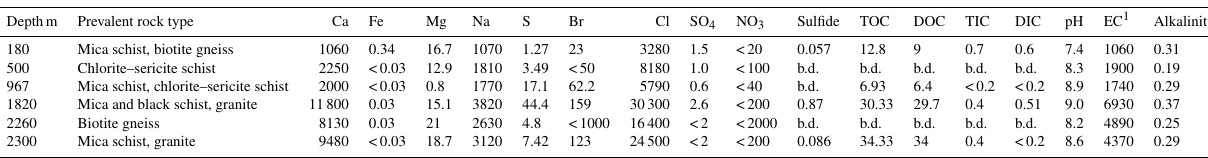
Table 1. Hydrogeochemical characteristics of six fracture zones of Outokumpu. Concentrations for cations and anions are given in mgL − 1 , EC in mSm − 1 and alkalinity in mmolL − 1